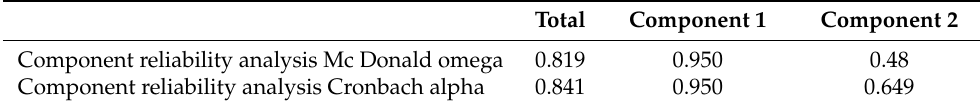
Table 10. Reliability